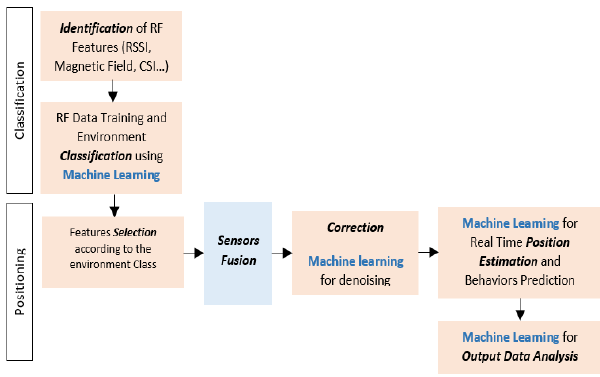
Figure 6. Machine learning applications in IoT positioning system